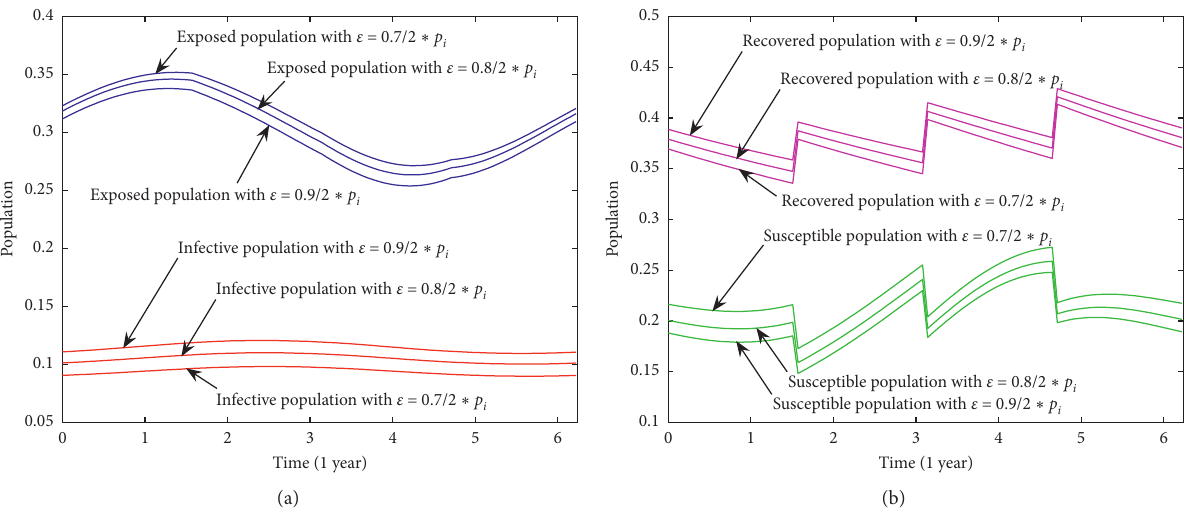
Figure 6: Exposed population, infective population, recovered population, and susceptible population with ϵ � 0 . 9/2 π , ϵ � 0 . 8/2 π , and ϵ � 0 . 7/2 π